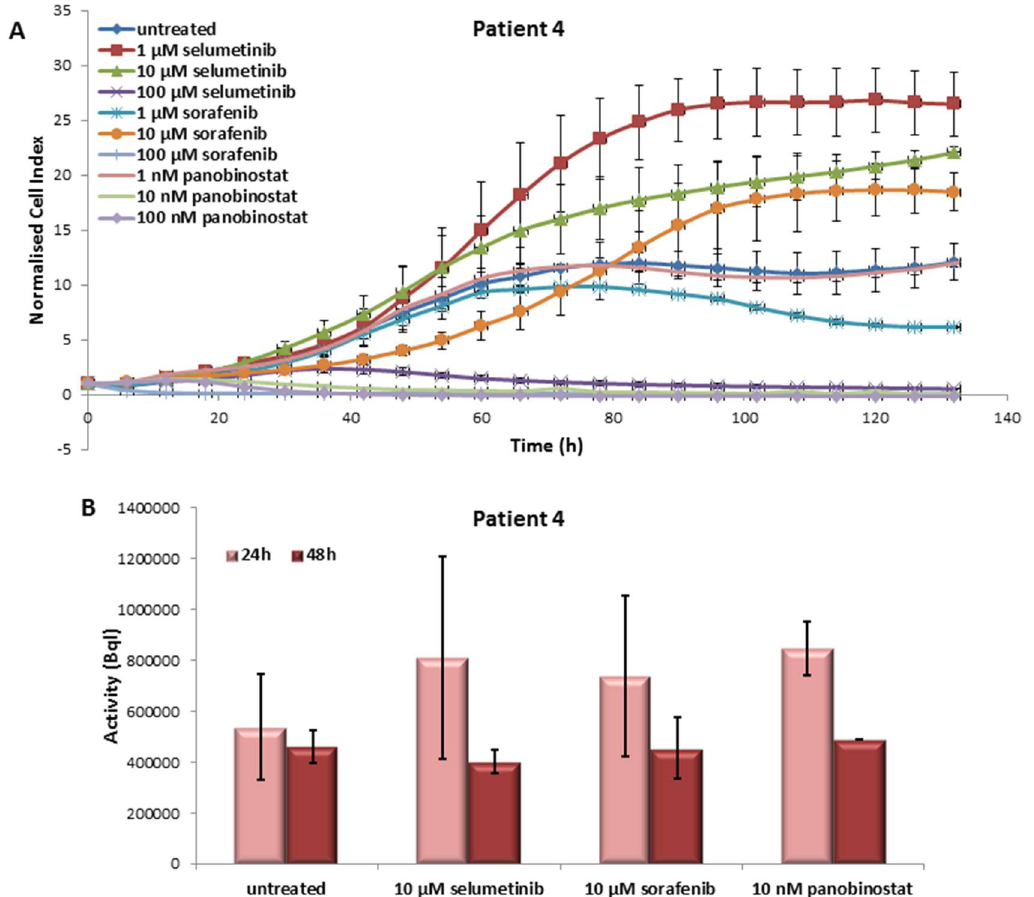
Figure 7. Effects of selumetinib, sorafenib and panobinostat on cell viability and RAI-U. Real-time cell viability of PDTT (PDTC—Patient 4) cells treated with 1 to 100 µM selumetinib and sorafenib and 1 to 100 nM panobinostat ( A ). RAI-U after 24 and 48 h of treatment with 10 µM selumetinib, 10 µM sorafenib and 10 nM panobinostat ( B ). Shown are means of experiments performed in triplicates ± SD ( A )/SEM ( B ).